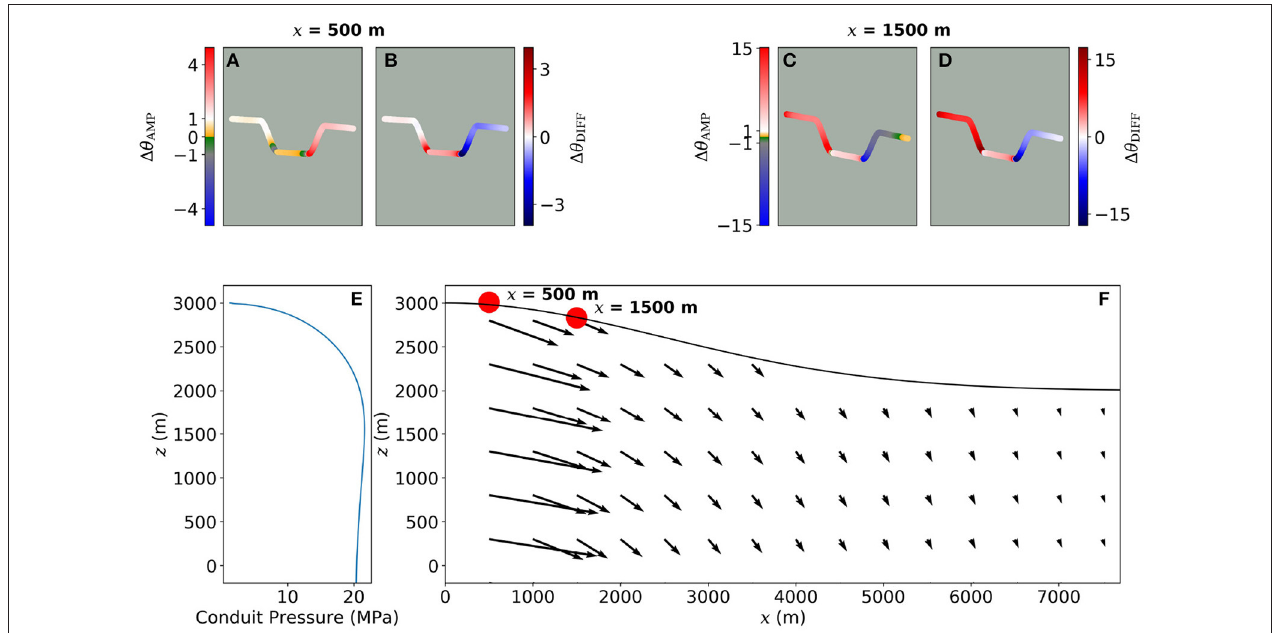
FIGURE 8 | (A–D) Amplification factor and difference due to the topographic effect on tilt produced by conduit pressure, where opposing slopes are included at either x = 500 or 1,500 m, as indicated by red dots. (E) Depth variant pressure profile from flow modeling of Marsden et al. (2019). (F) The amplitude and orientation of the displacement field produced by shear